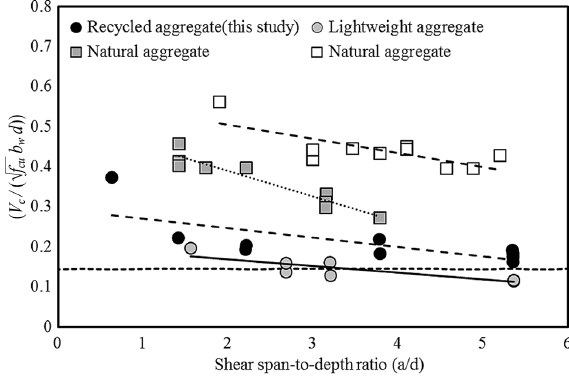
Fig. 7. Effect of longitudinal reinforcement ratio on ultimate shear